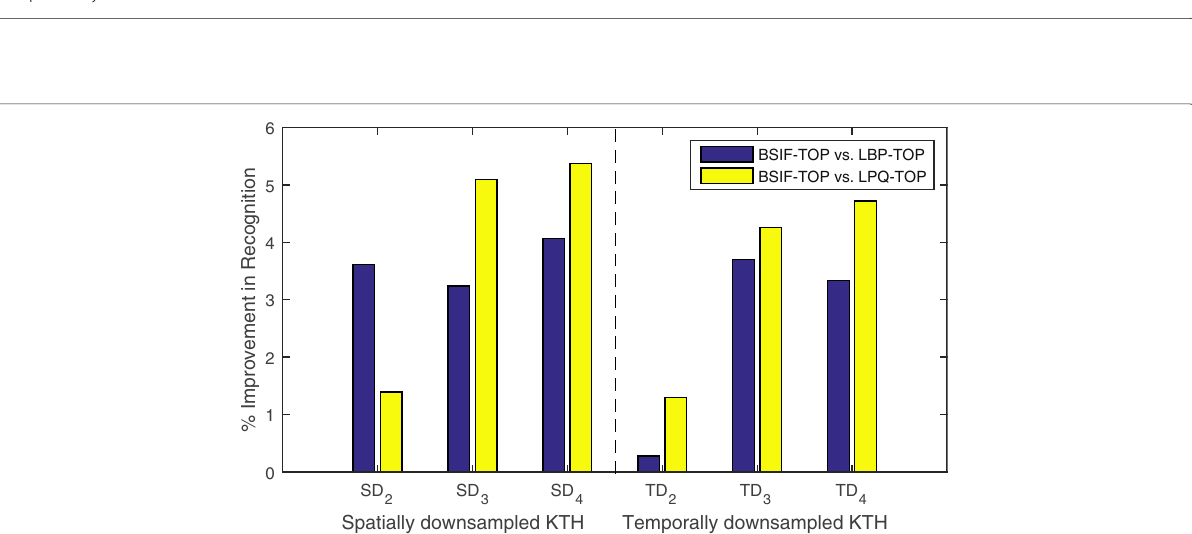
Fig. 5 Percentage improvement of BSIF-TOP over LBP-TOP and LPQ-TOP when combined with STIP on downsampled KTH